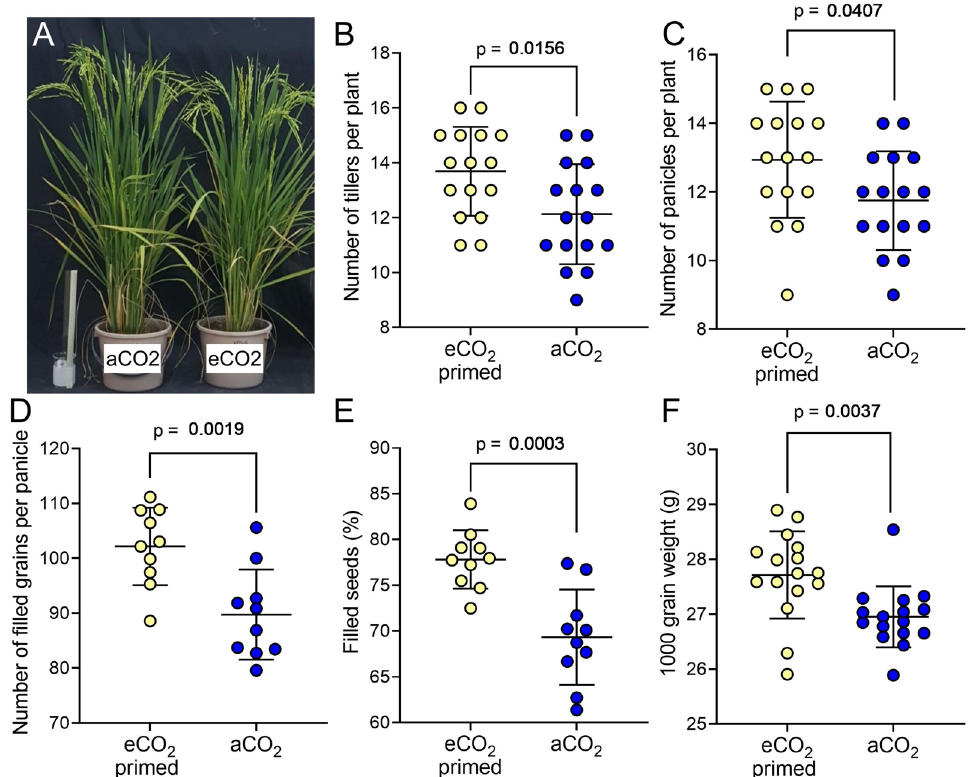
Fig. 3 Yeast‑derived eCO 2 primed plants grown to maturity in semi‑field conditions have increased growth and yield. A aCO 2 and eCO 2 ‑primed MR219 plants at 90 DAS. B – F For plants harvested at 141 DAS, number of tillers per plant ( B ), number of panicles per plant ( C ), number of filled grains per panicle ( D ), the percentage of grains which are filled ( E ) and 1000 grain weight ( F ) are significantly higher in eCO 2 ‑primed plants. Unpaired t tests, p values as shown. B , C , F n 16; D , E n = =